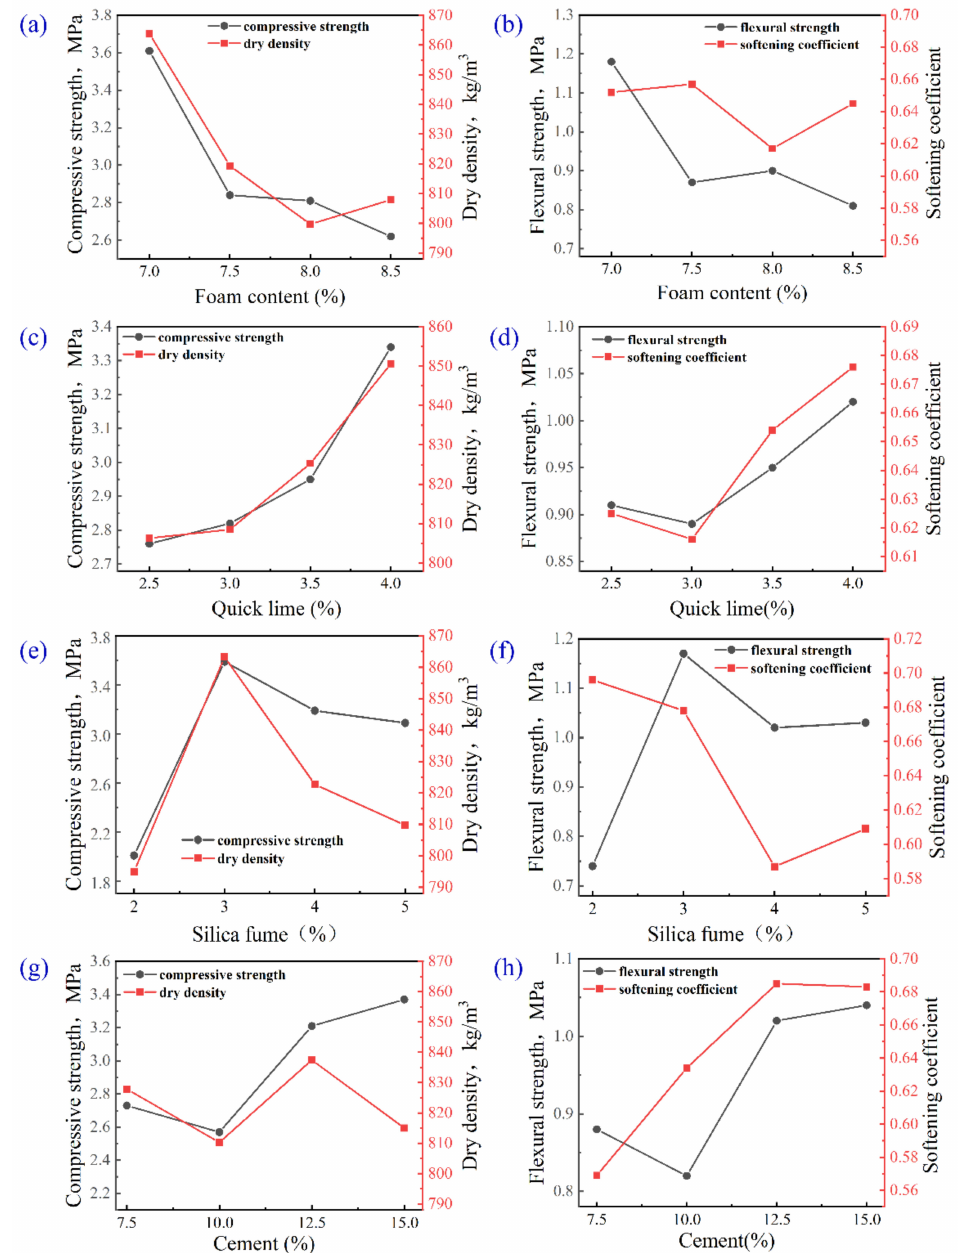
Figure 4. Relationship between strength, dry density and softening coefficient of each factor. ( a ) Ef- fects of foam content on compressive strength and dry density;( b ) Effects of foam content on flexural strength and softening coefficient; ( c ) Effects of quick lime on compressive strength and dry density; ( d ) Effects of quick lime on flexural strength and softening coefficient; ( e ) Effects of silica fume on compressive strength and dry density; ( f ) Effects of silica fume on flexural strength and softening coefficient; ( g ) Effects of cement on compressive strength and dry density; ( h ) Effects of cement on flexural strength and softening